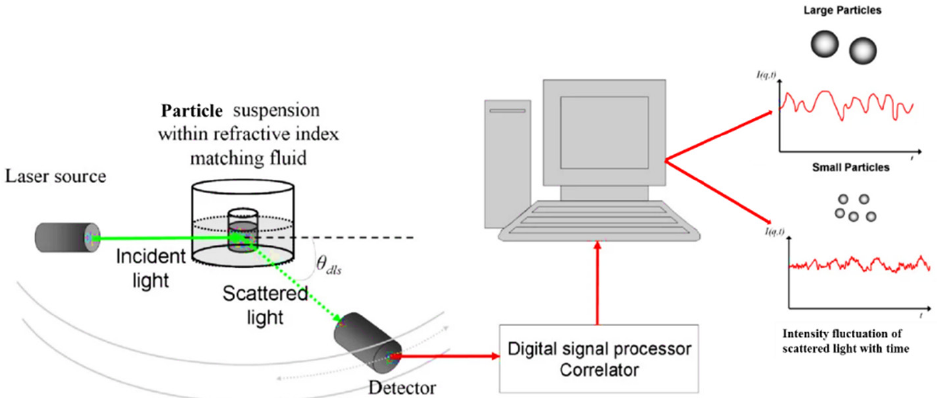
Figure 8. Optical arrangement of a common experimental setup for studies of dynamic light scatter- ing. Ref [84] Reproduced with permission from Lim et al., Nanoscale Research Letters; published by Springeropen, 2013.